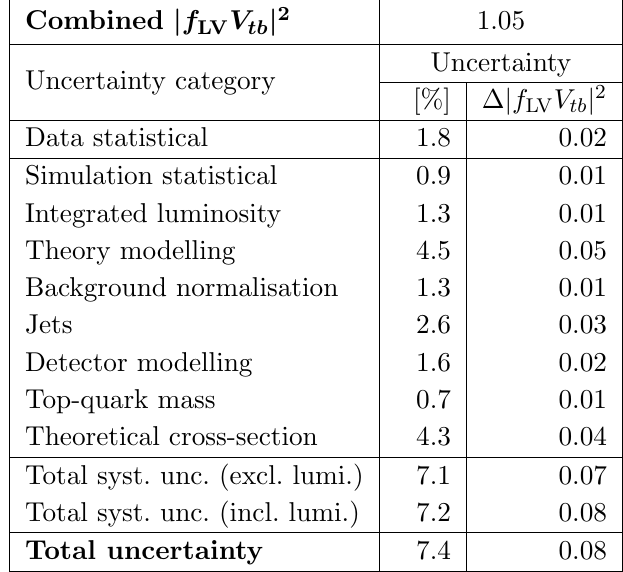
Table 7 . Contributions from each experimental and theoretical uncertainty category to the overall 2 combination. The total uncertainty is computed by adding in quadrature all of the indi- f LV V tb j j vidual systematic uncertainties (including the integrated luminosity and theoretical cross-section) and the statistical uncertainty in data.